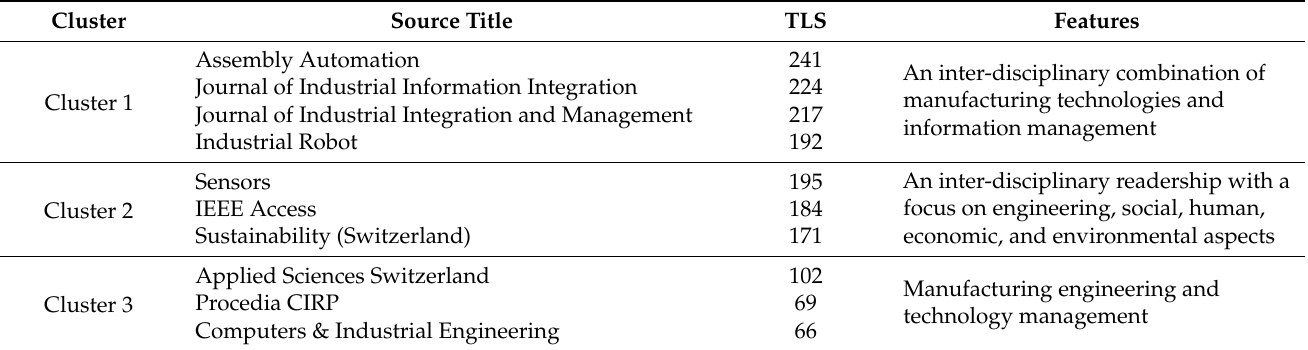
Table 4. Co-citation clusters of smart logistics in Industry